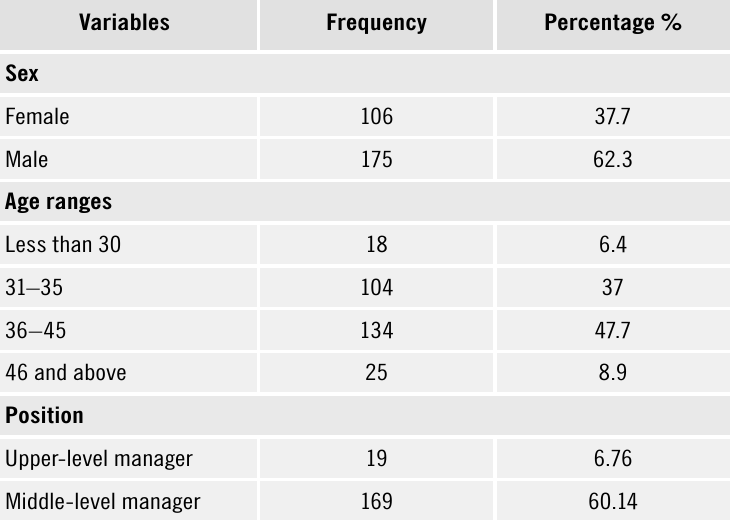
Table 2. Respondents’